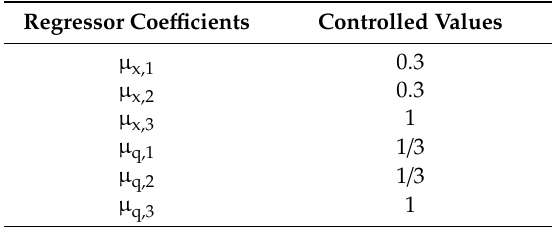
Table 1. Controlled regressor coe ffi